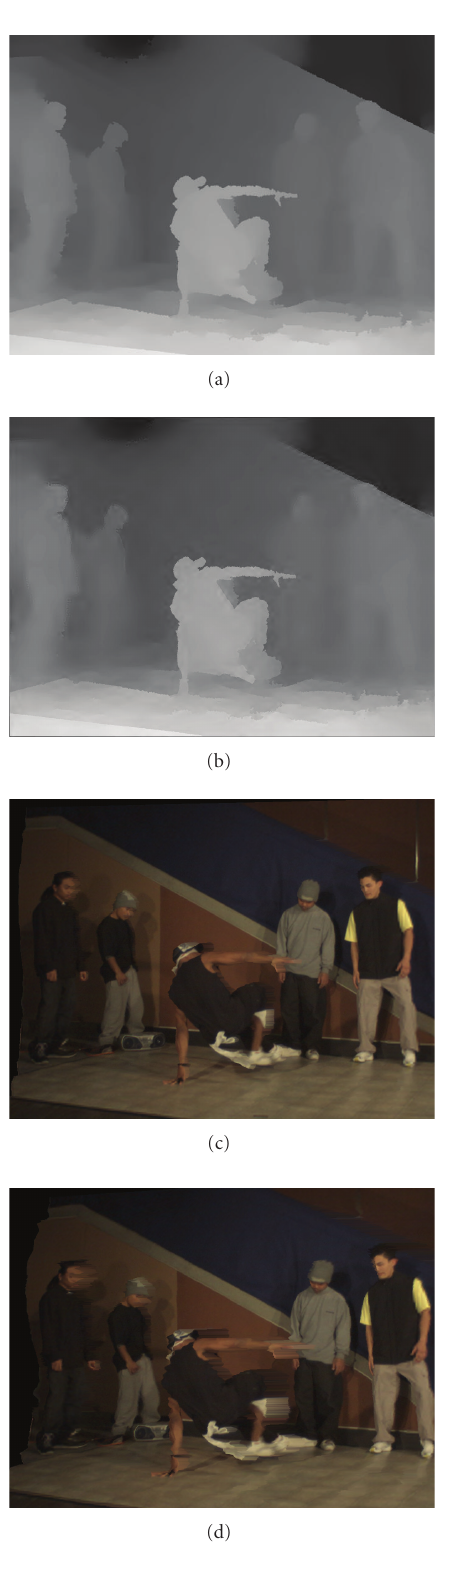
Figure 18: Breakdance : (a) depth map from camera 4, (b) depth map from camera 4 corrupted by depth packet losses, (c) warping of the corresponding frame to viewpoint 3 using the corrupted depth, (d) warping of the corresponding frame to viewpoint 1 using the corrupted depth.